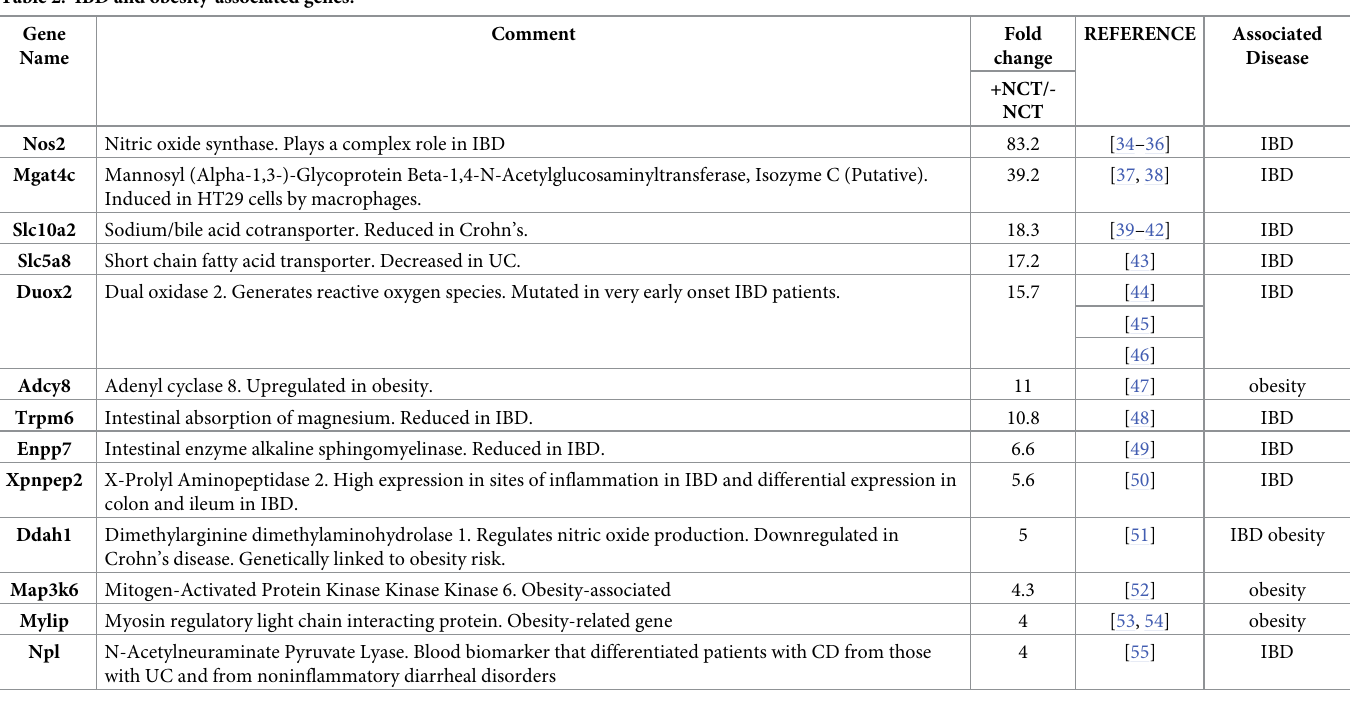
Table 2. IBD and obesity-associated genes.